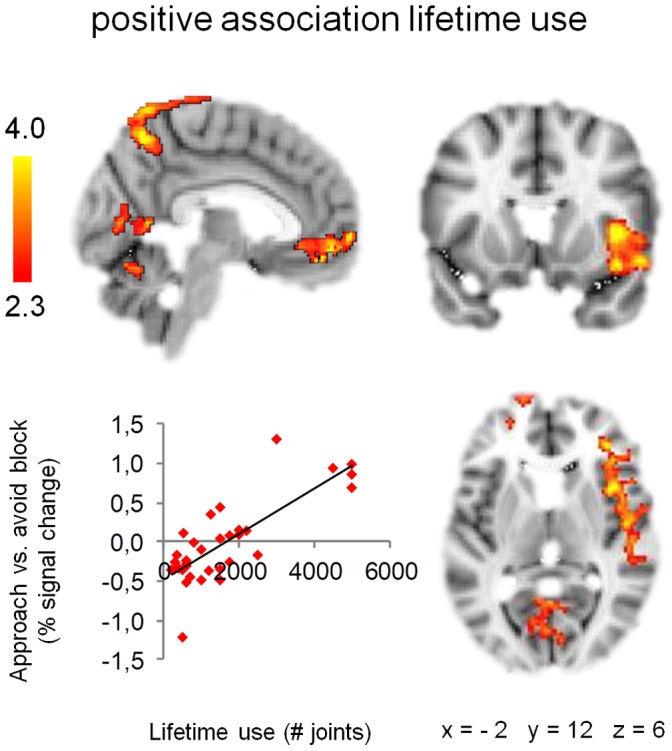
Association approach-bias activation patterns and lifetime cannabis use.Approach-bias activation patterns in right insula, medial frontal gyrus, precuneus, cerebellum, and occipital cortex are positively associated with lifetime cannabis use among heavy cannabis users. Scatter plot shows association lifetime use and average percent signal change extracted from significant clusters. Clusters of significant activation (Z >2.3, whole-brain cluster-corrected at p<0.05) are overlaid on a standard MNI brain. Right side of the brain is depicted at right side.